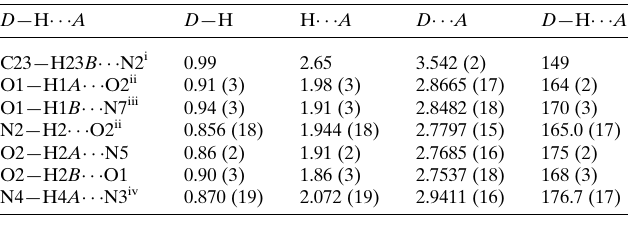
Table 3 Hydrogen-bond geometry (A˚ , (cid:3) ) for (1) (cid:2) 2H 2 O.